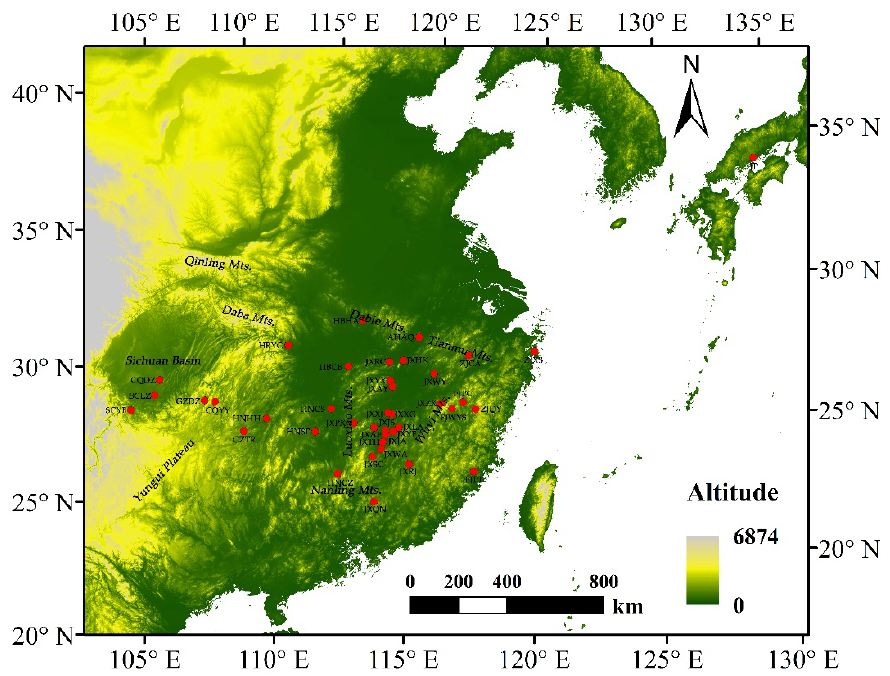
Figure 1. Geographical distribution of the plant materials. Solid dots represent populations collected in natural distribution areas in China and Japan. Table 1. Geographical locations, sample size and sample numbers of 40 C. camphora populations in China and Japan.